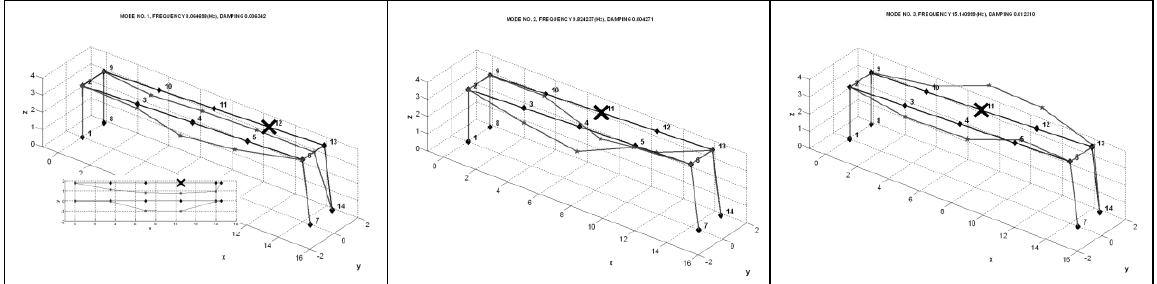
Fig. 2. Modeshapes with the calculated optimal reference degrees of freedom (marked with black